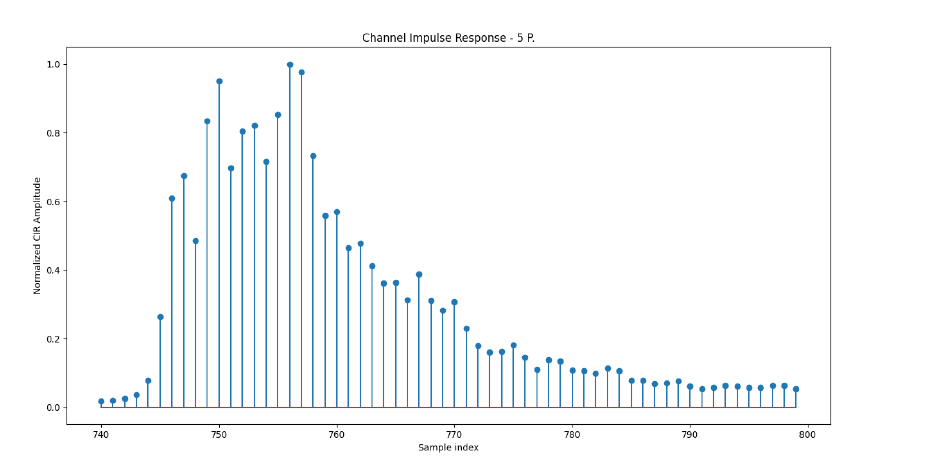
Figure 4. Normalized Channel Impulse Response, Room A with 5 People moving in the